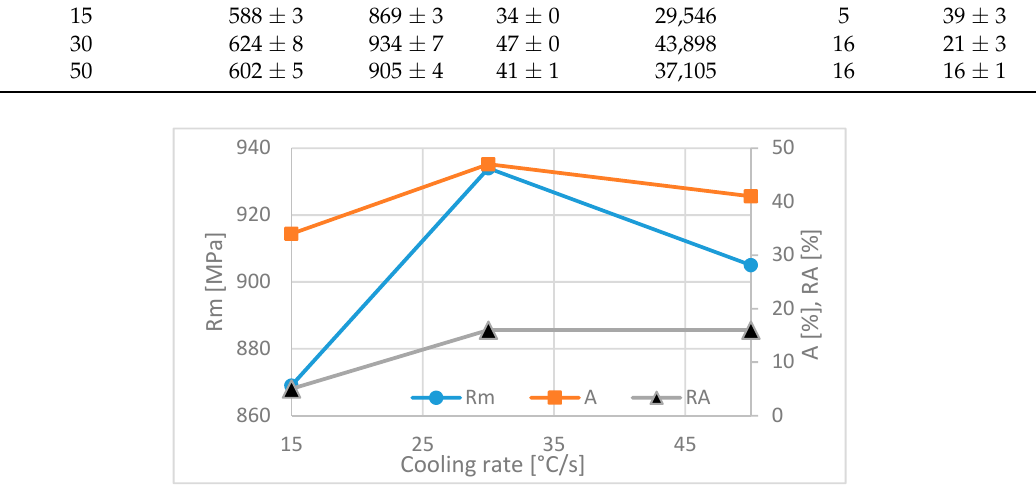
Figure 7. Effect of cooling rate on strength (Rm), total elongation (A), retained austenite (RA).